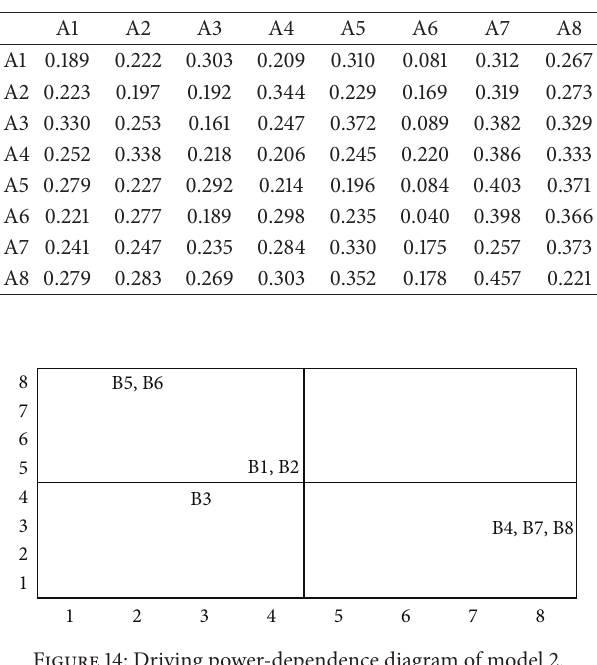
Table 10: Total relation matrix of model 1.